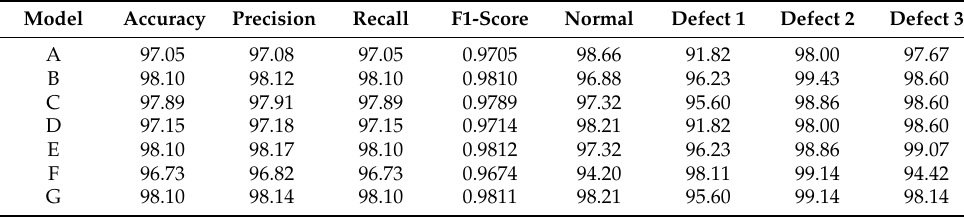
Table 7. Performance of WTBMobileNet on different augmentation.